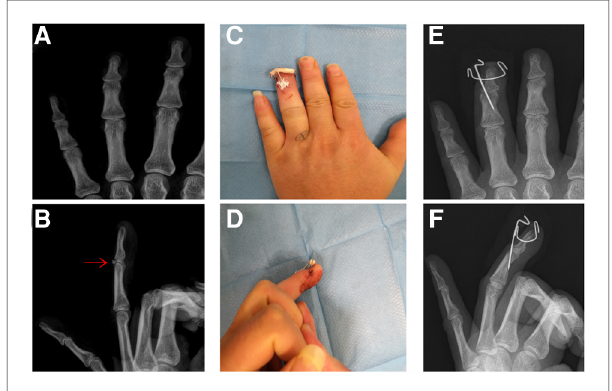
FIGURE 2 Preoperative and postoperative data of patient No.4. ( A,B ). Preoperative X-ray; the avulsion fracture (red arrow). ( C,D ). Postoperative X-ray. ( E,F ). Postoperative